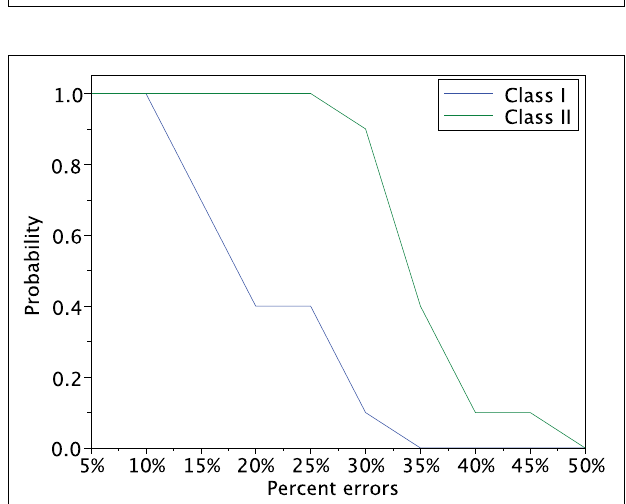
FIGURE 13 | Relevance of the overlap and the synchronization in Figure 12.